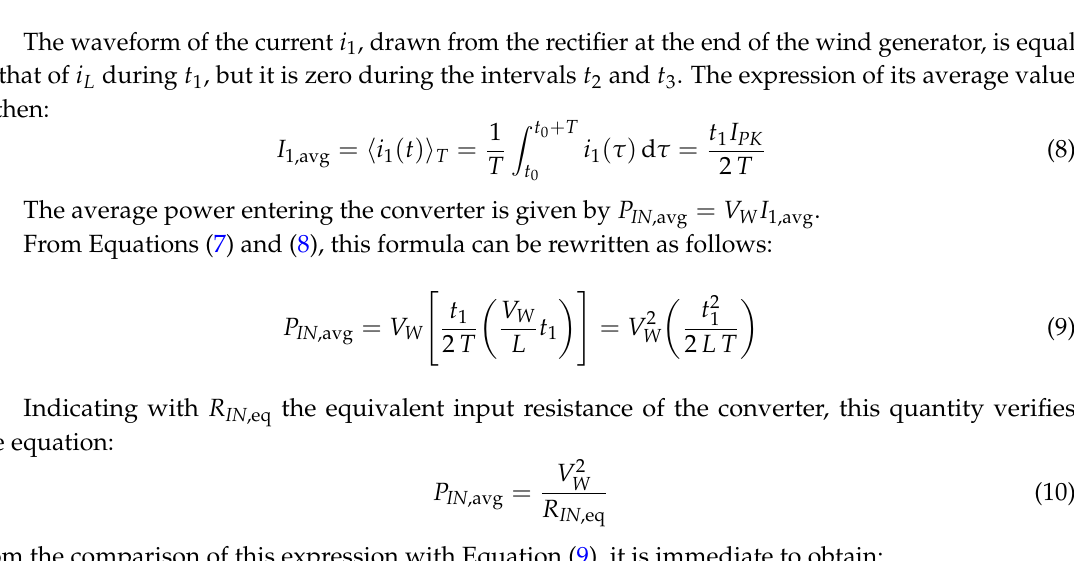
Figure 6. Waveform of the current through the inductance L, when the DC-DC is operating in fixed-frequency discontinuous current